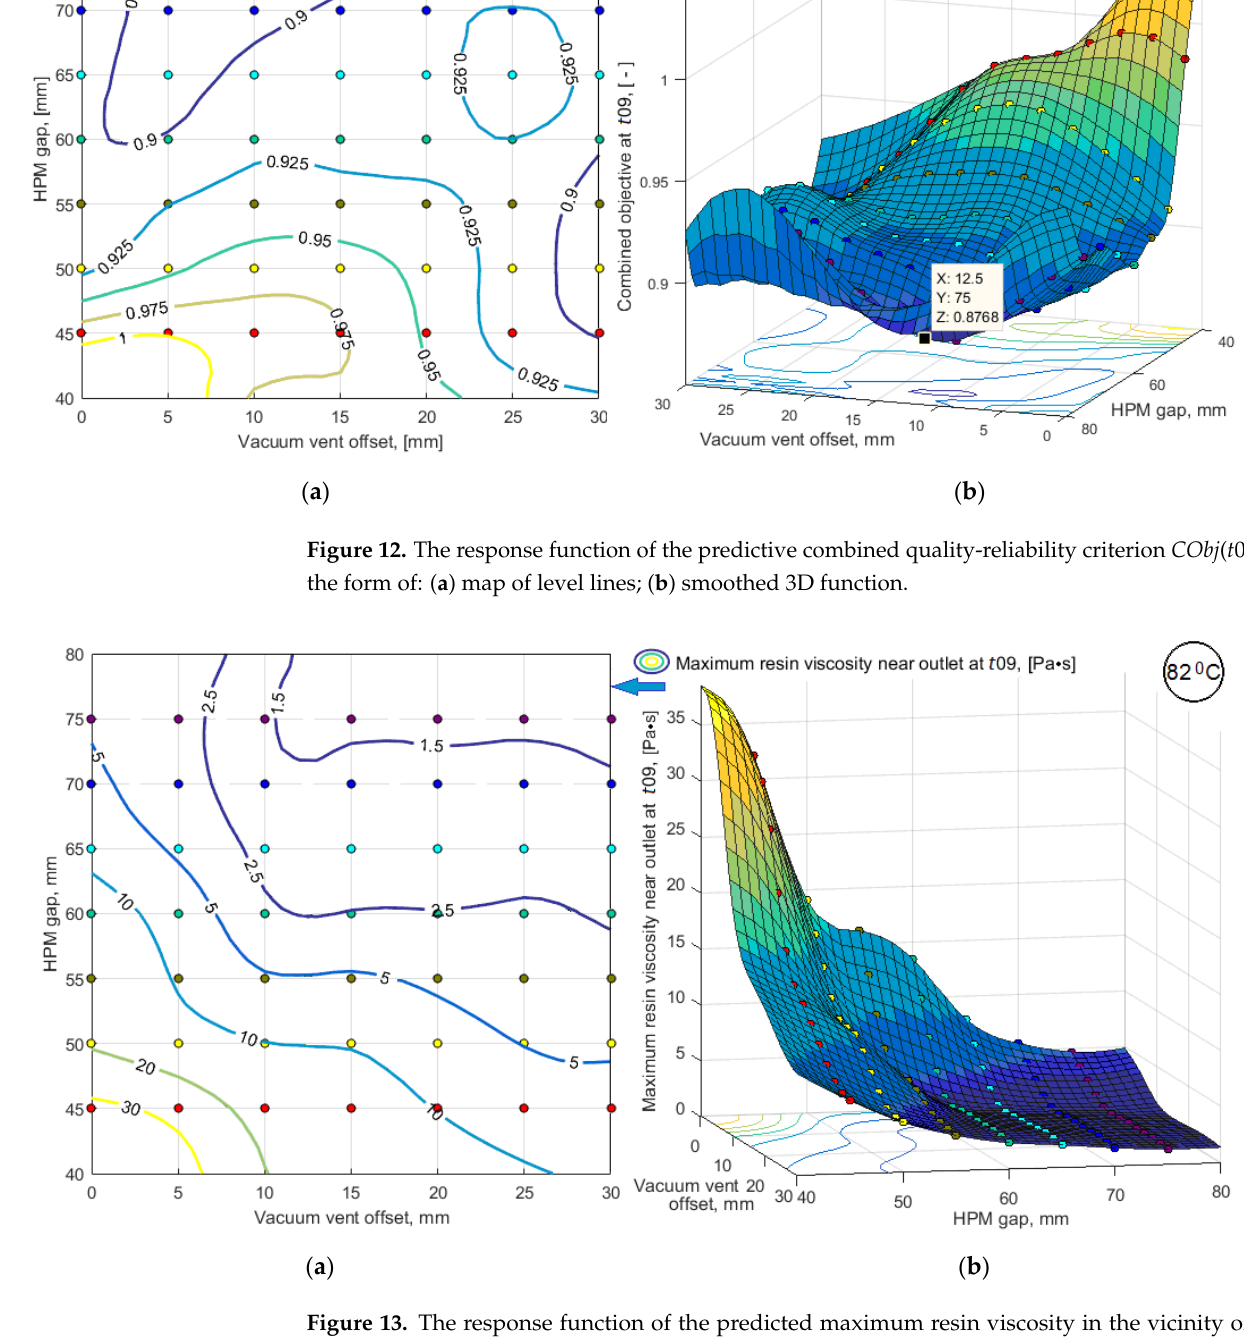
Figure 13. The response function of the predicted maximum resin viscosity in the vicinity of the   09max t out  in the form of: ( a ) map of level lines; ( b ) smoothed 3D function. vacuum vent  